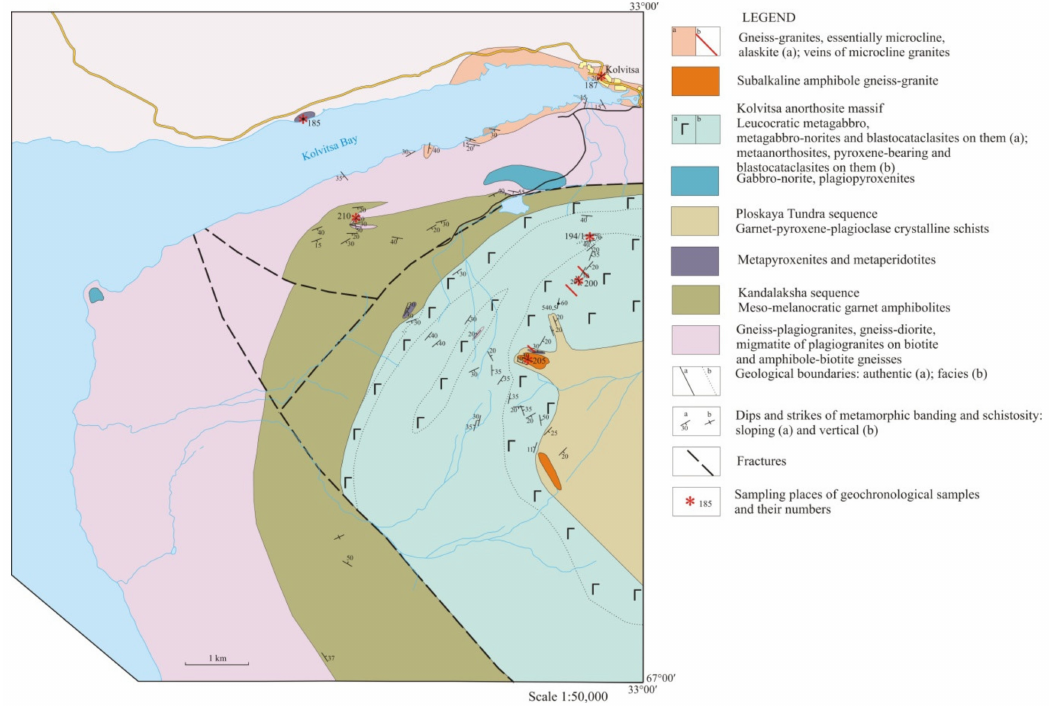
Figure 2. Scheme of the geological structure of the northwestern part of the Kolvitsa anorthosite